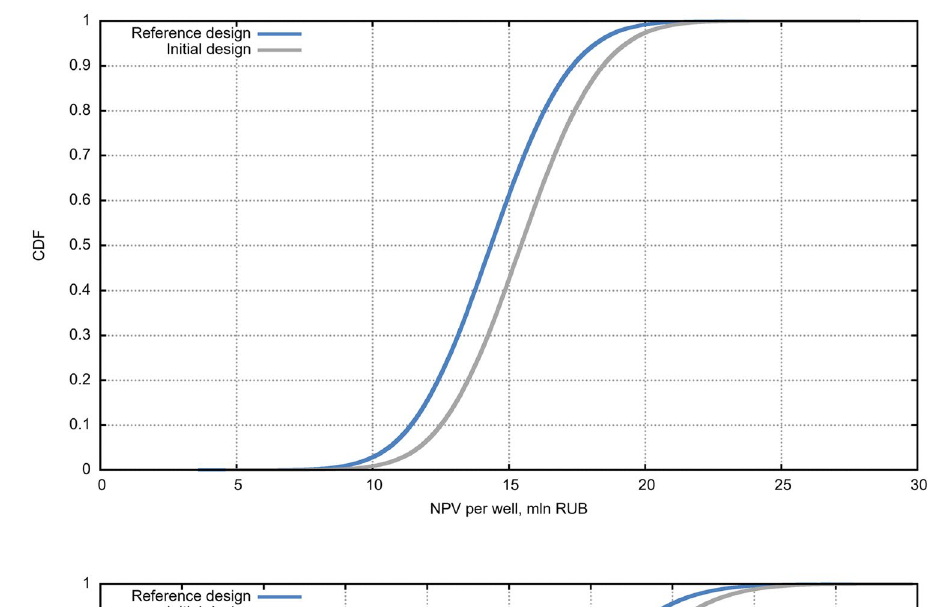
Fig. 17 Cumulative distribution functions (CDF) for the NPV of the drilling projects according to scenario S2